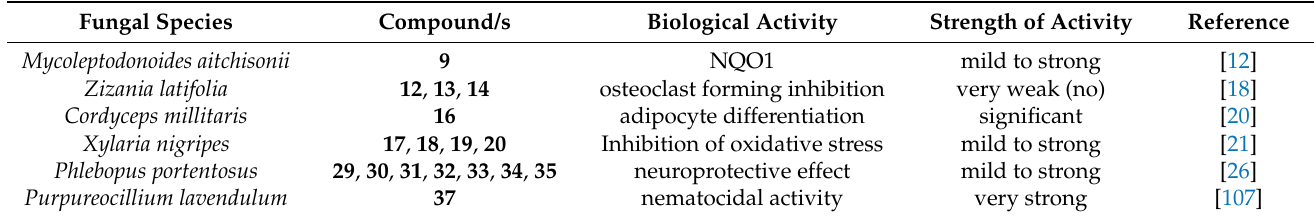
Table 1. Biological activity of compounds isolated from fungal